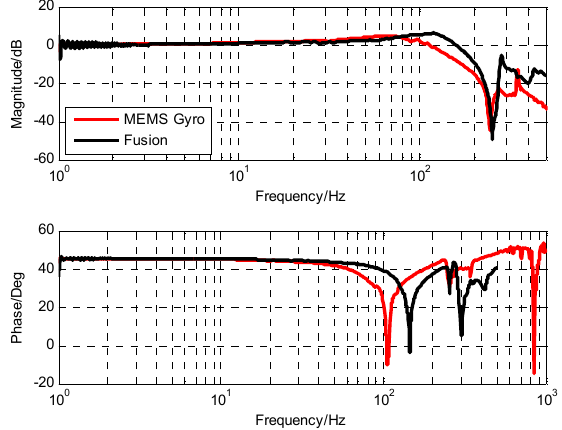
Figure 18. The system control result based on closed-loop fusion with optimal design: ( a ) The frequency response of open-loop; ( b ) the frequency response of closed-loop.